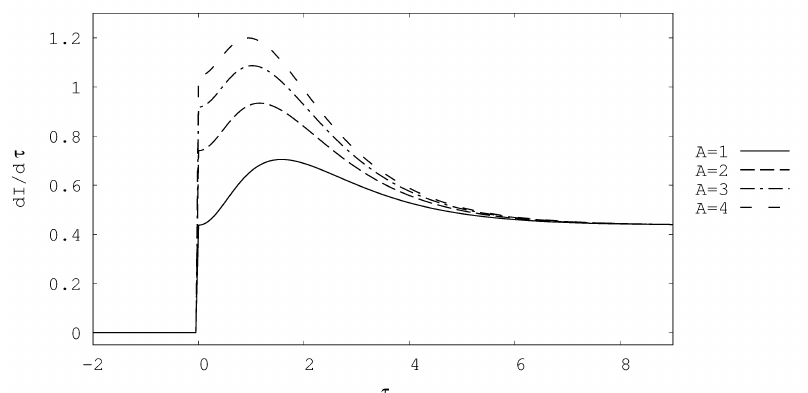
Figure 5 . Time dependence of the WDW action in the non-rotating case for di(cid:11)erent values of the parameter A . We set G = 1, l = 1, r 0 = 1 and (cid:23) = 2.